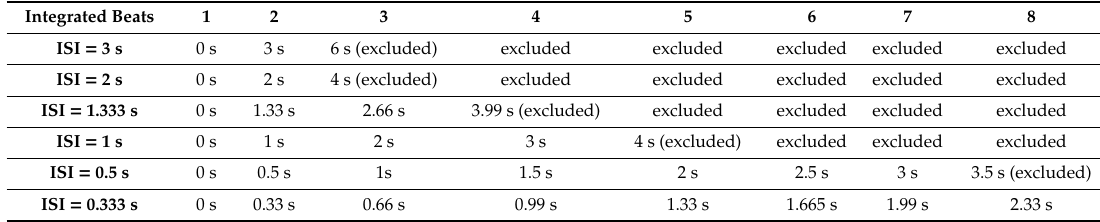
Table A1. Temporal integration intervals (TI) depending on ISI and integrated beats Individual